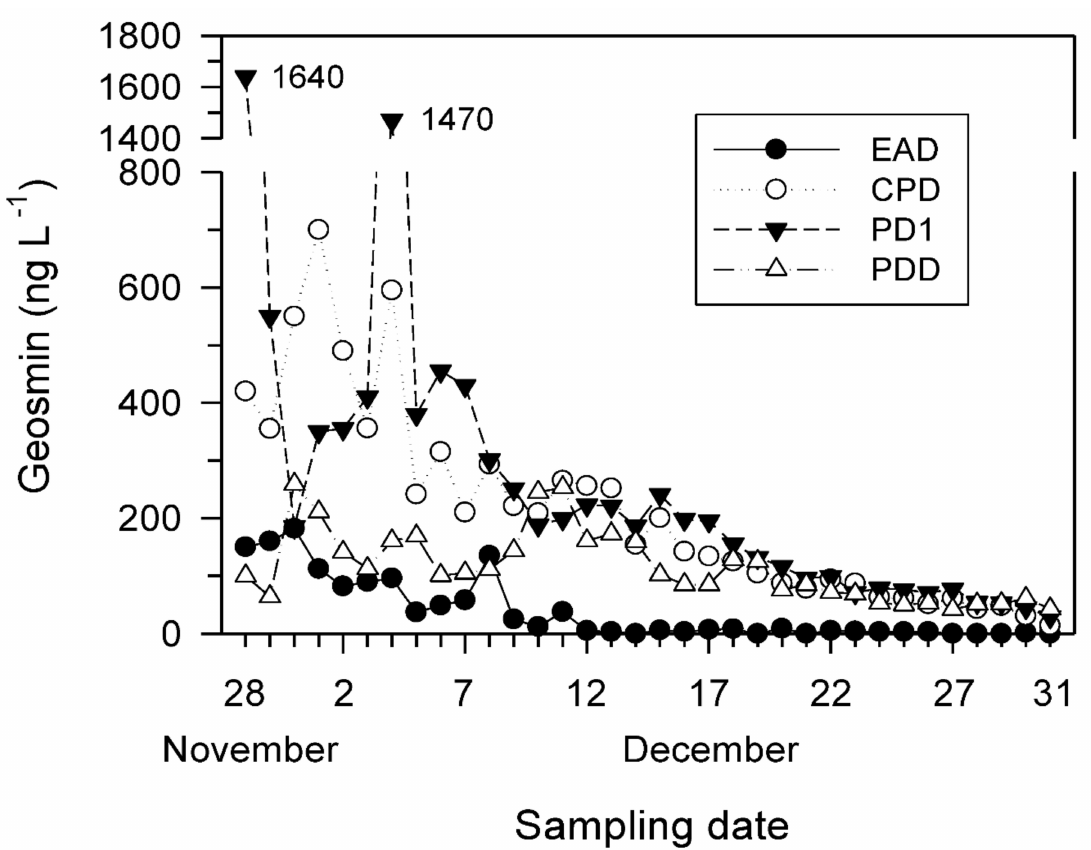
Figure 7. Daily variations in the geosmin concentration determined in the four stations of the Euiam and Cheongpyeong Reservoirs (EAD and CPD, respectively) of the North Han River and Paldang Reservoir (PDD) of the Han River from 28 November to 31 December